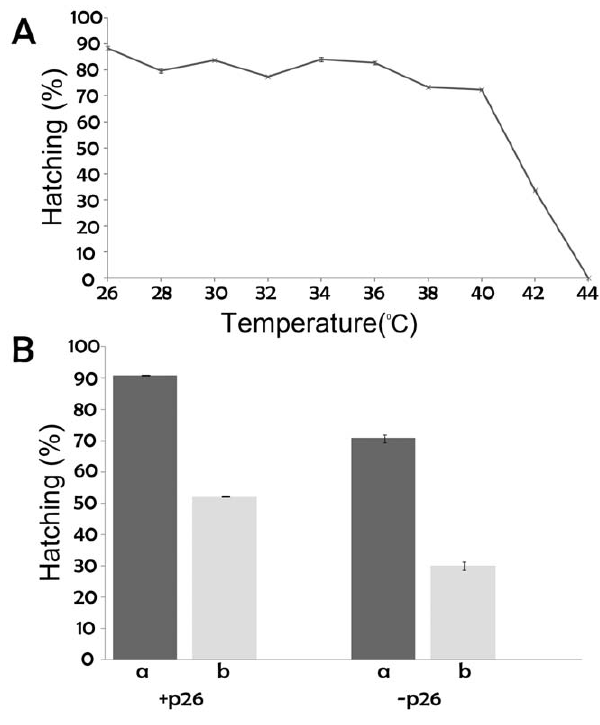
Figure 7. p26 increases cyst tolerance to heat shock. A. Hydrated commercial cysts containing p26 were heat shocked for 30 min at the temperatures indicated in the graph, cooled on ice, incubated in sea water at room temperature and observed for hatching. The experiment was done in triplicate and standard error is shown for each measurement. B. Cysts containing ( + p26) and lacking ( 2 p26) p26 were either held at room temperature (a) or heated at 41 u C for 30 min (b), cooled on ice, incubated in sea water and observed for hatching. Results are presented as the hatching percentage with hatching equivalent to viability. The experiment was done in duplicate with separate broods of cysts and the error bars represent standard error.